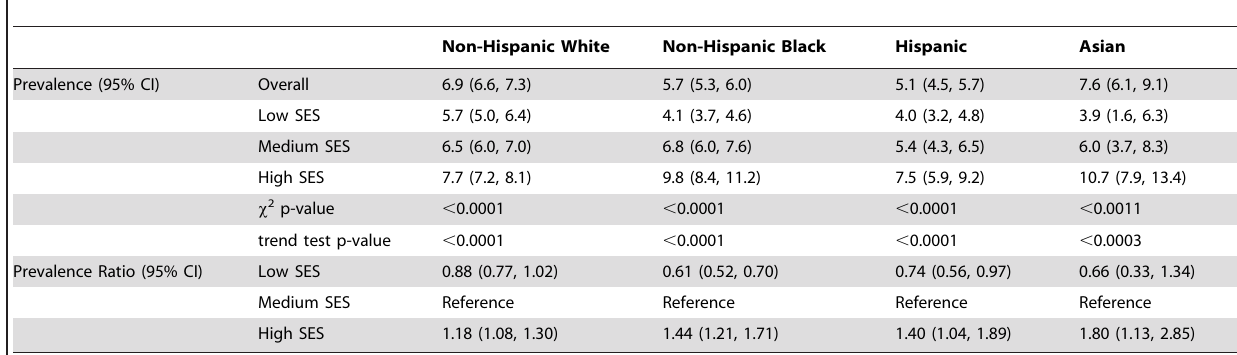
Table 3. Prevalence (95% CI a ) of ASD per 1,000 8-Year-Olds and Ratios of ASD Prevalence by SES b , Stratified by Race/Ethnicity c .